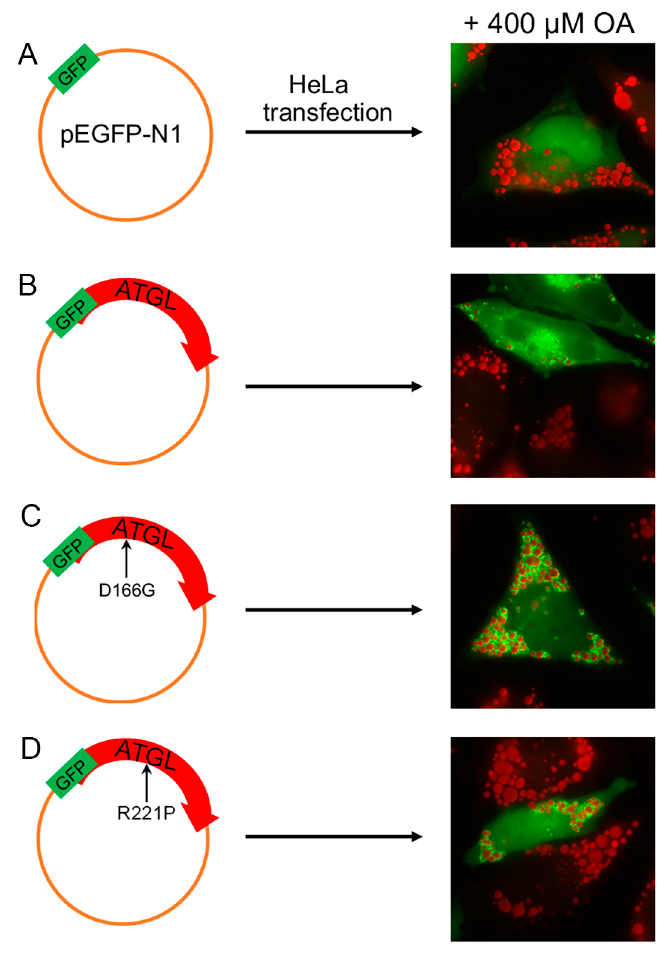
Figure 2. Qualitative and quantitative evaluation of LDs in HeLa cells transiently transfected with ATGL wild-type and mutant proteins. After incubation for 18 h with oleic acid (OA) (400 µ M) complexed to bovine serum albumin (BSA) (6:1 molar ratio), HeLa cells were transiently transfected with either phosphor (p) enhanced GFP (EGFP; A ), pATGL-EGFP ( B ), pATGL(D166G)-EGFP ( C ), or pATGL(R221P)-pEGFP ( D ). After 24 h, the cells were fixed and stained with Oil red O (ORO). Immunofluorescent imaging reveals that all ATGL proteins correctly localized to LDs. Quantification of LD number and size per cell was performed using the public-domain Java image-processing program WCIF ImageJ 1.35j (developed by W. Rasband; NIH, Bethesda, Maryland). Fluorescence of EGFP and ATGL-EGFP fusion proteins is shown in green. Magnification: 40 × . These data were previously published in a different format